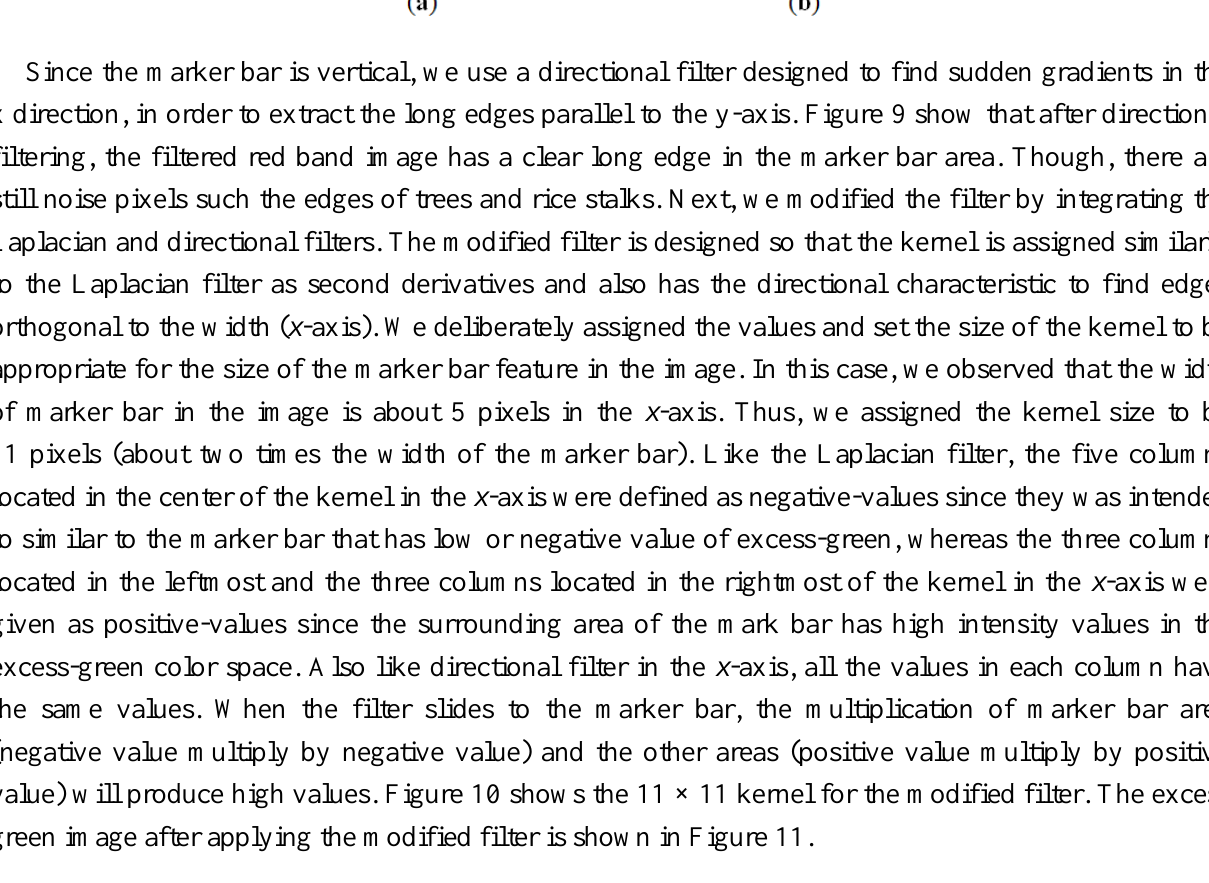
Figure 9. Filtered excess green image with x -direction